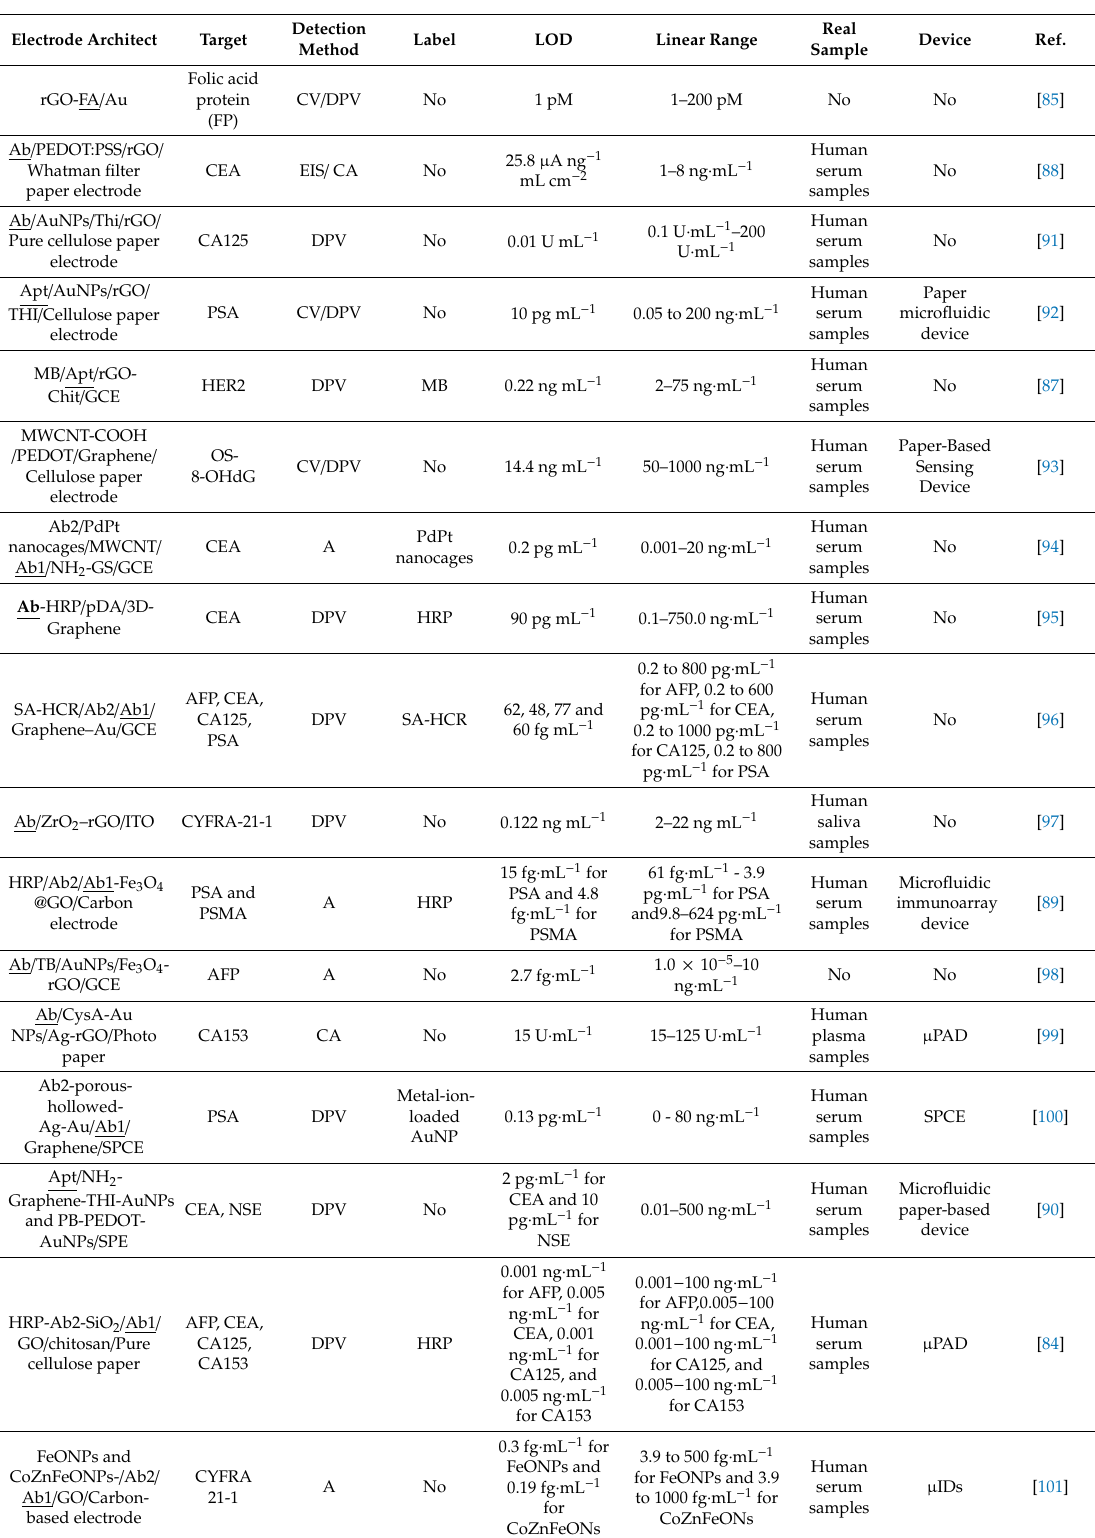
Table 2. Graphene-based electrochemical biosensors for protein cancer biomarker detection. The underlined terms are the